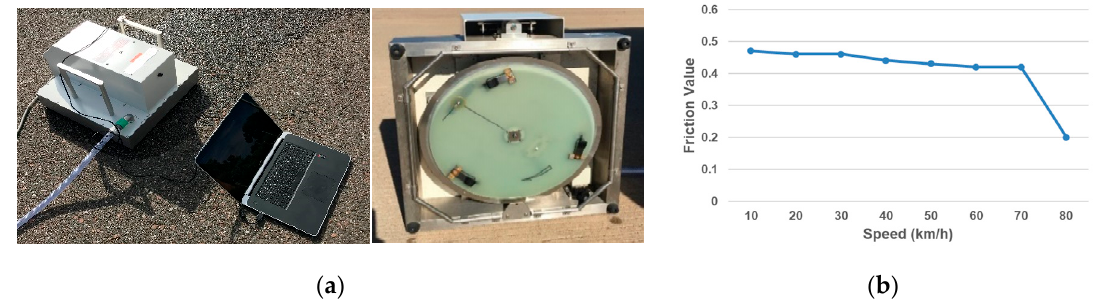
Figure 4. DFT and example data set: ( a ) Dynamic Friction Tester (DFT) (Nippo Sangyo Co., LTD., Tokyo, Japan); ( b ) Example DFT Friction Data.